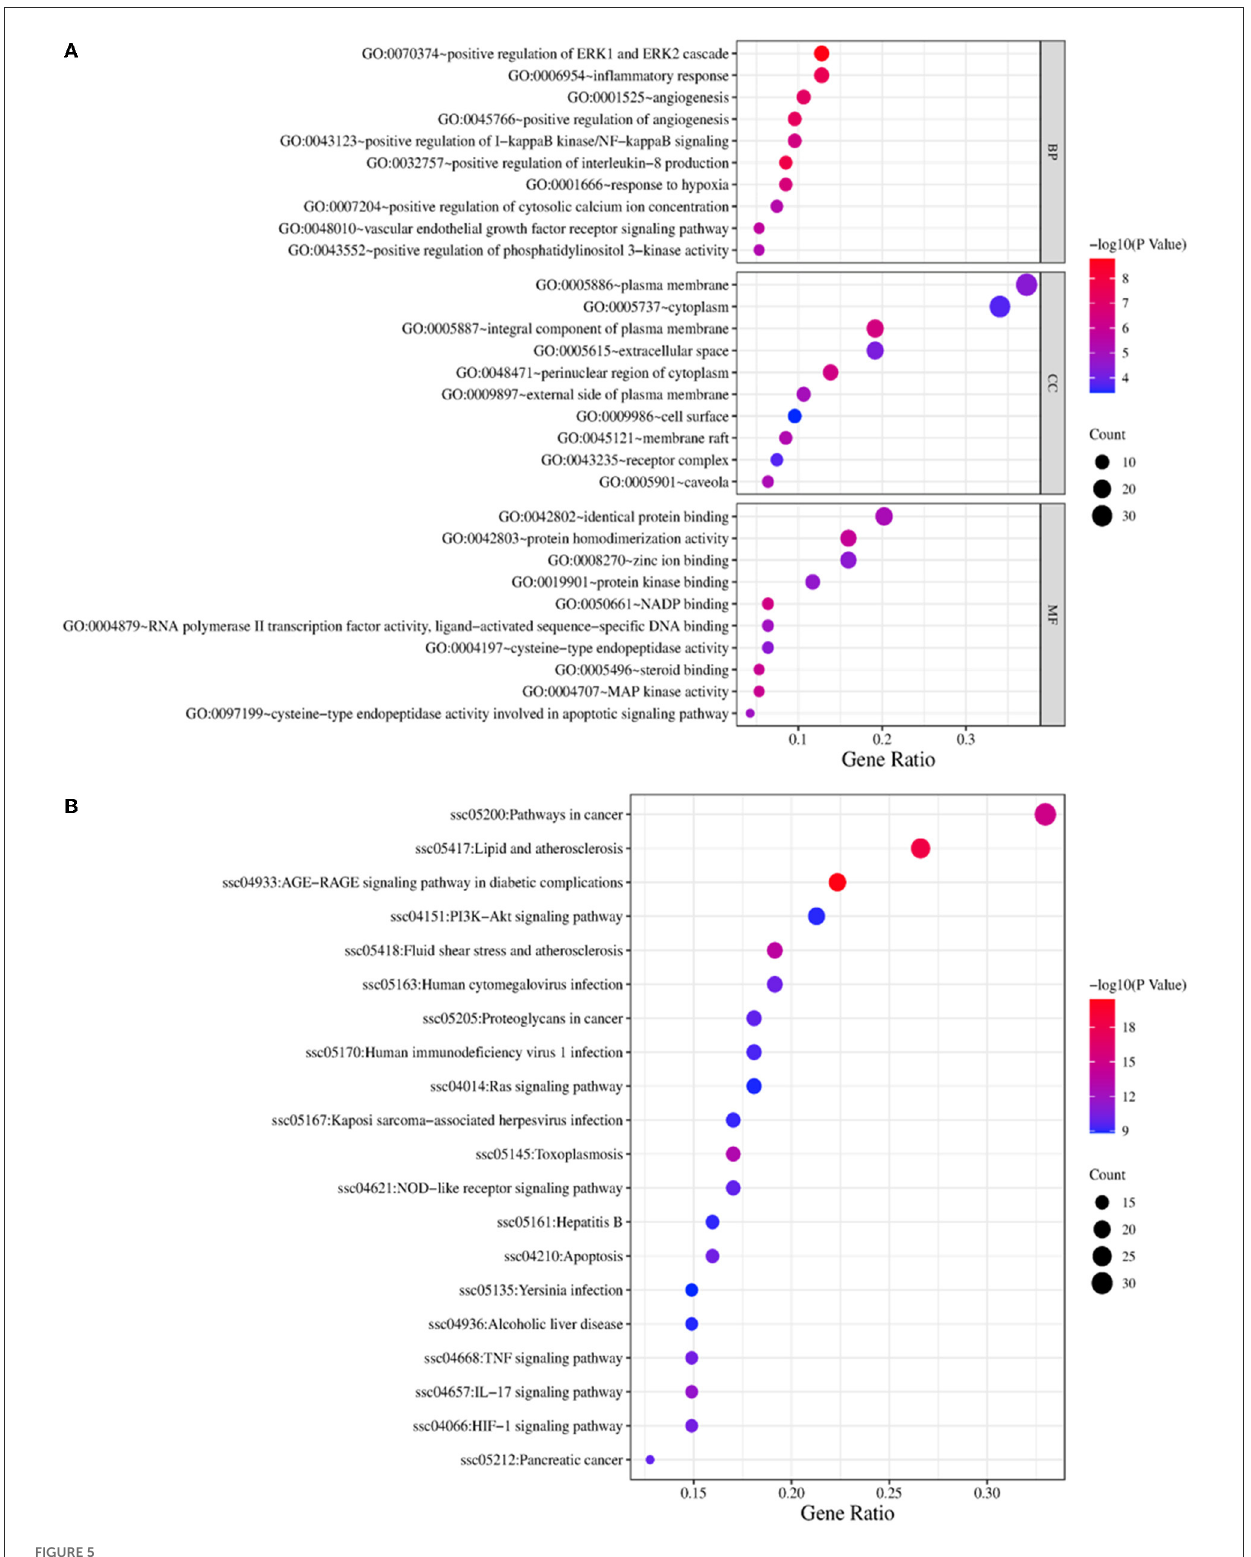
FIGURE5 GO (A) and KEGG (B) pathway enrichment analysis.